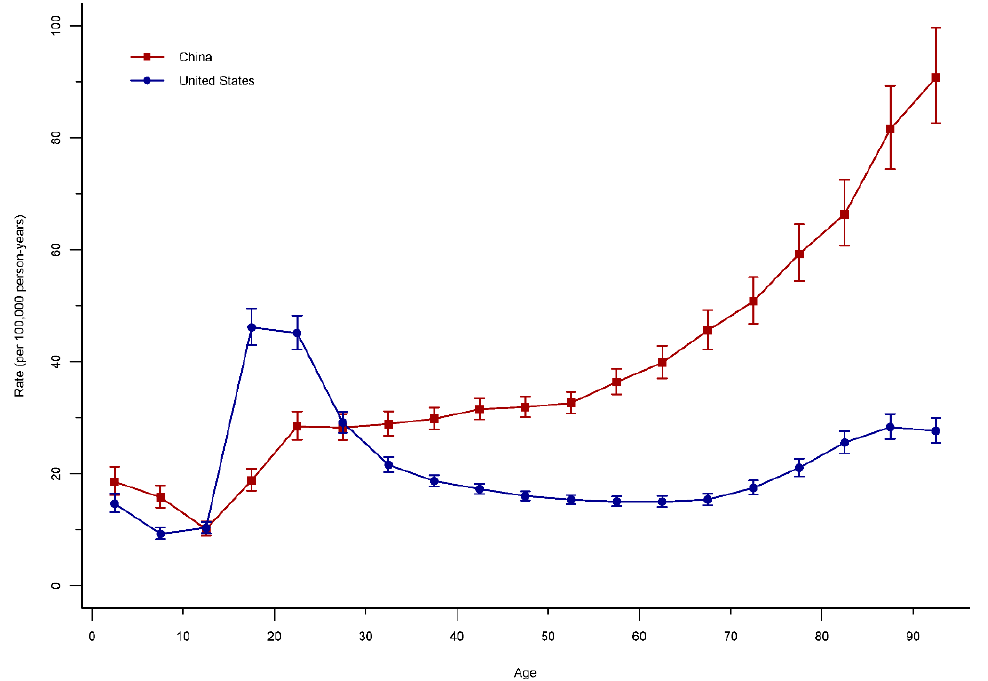
Figure 3. Longitudinal age curve of road injury mortality rate under the APC framework.